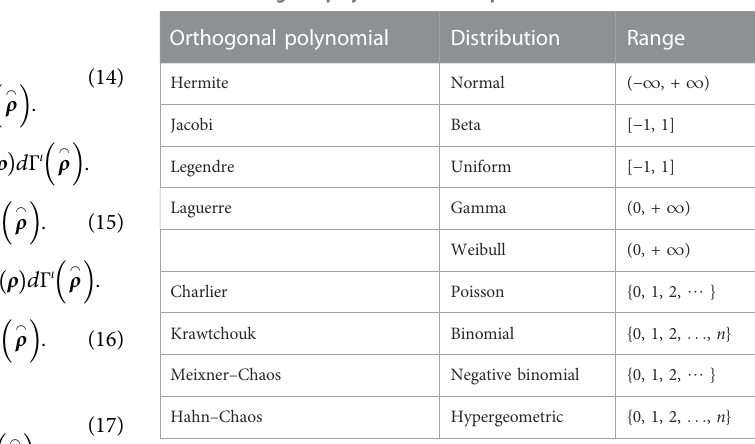
TABLE 1 Orthogonal polynomials with respect to the different